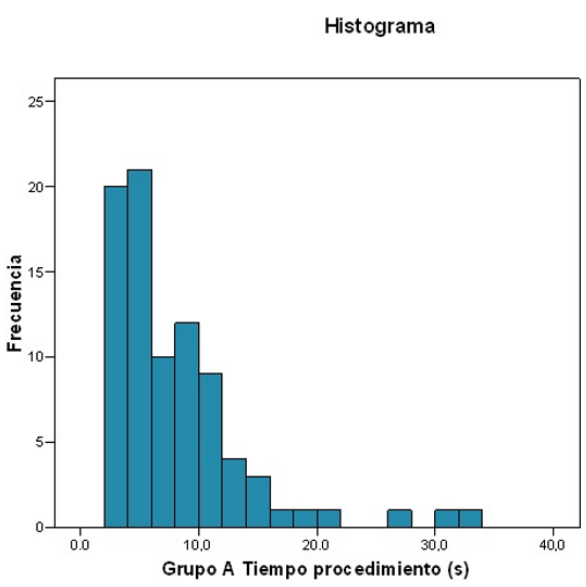
Figure 1. Histogram: Frequency of the duration of percutaneous Achilles